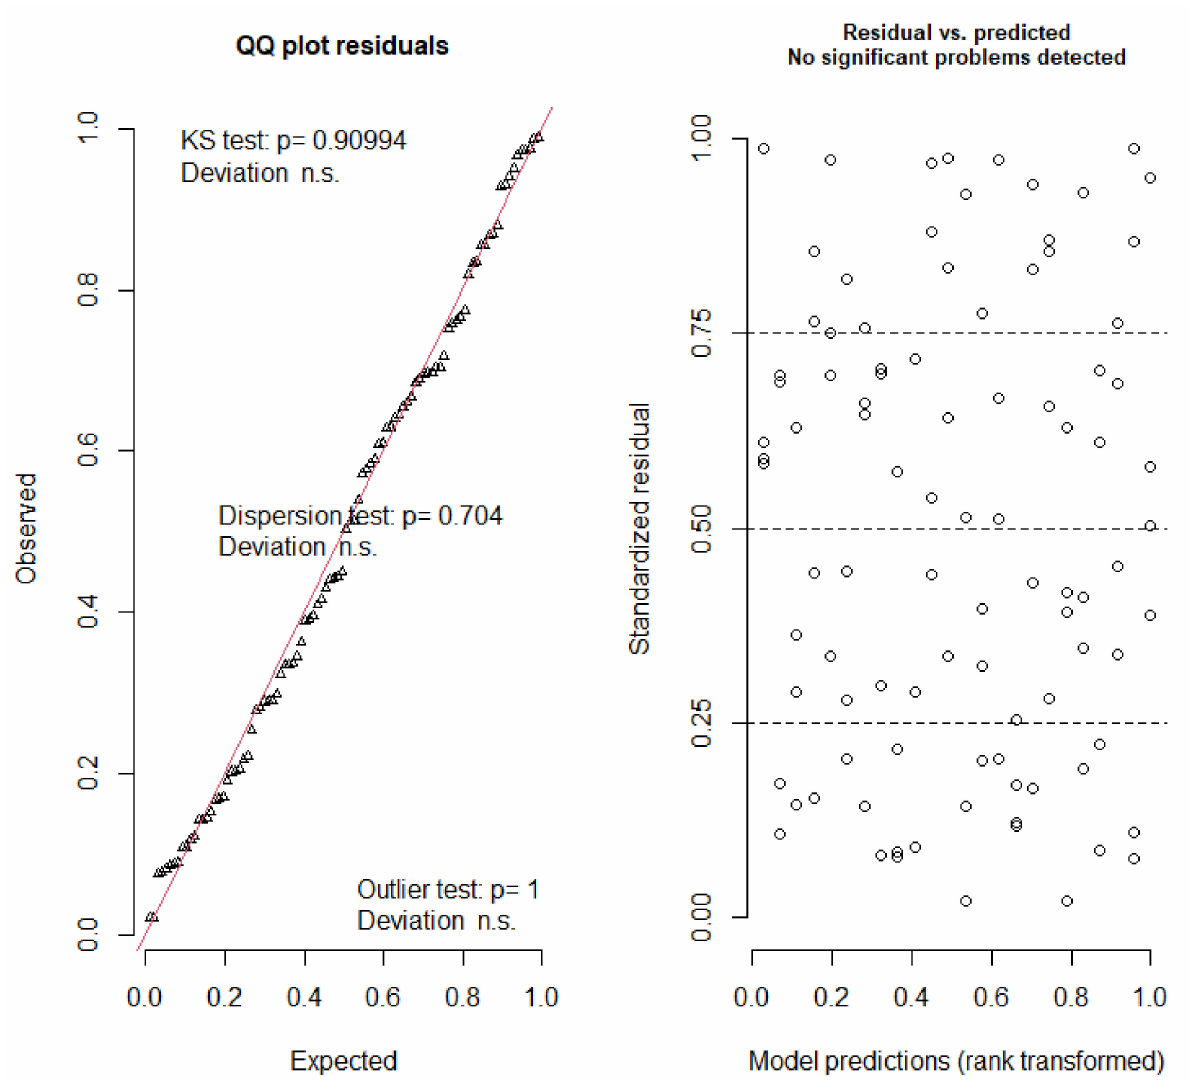
Figure A4. Q-Q plot and the residuals versus the predicted for the rate of catch model of Lucilia sericata